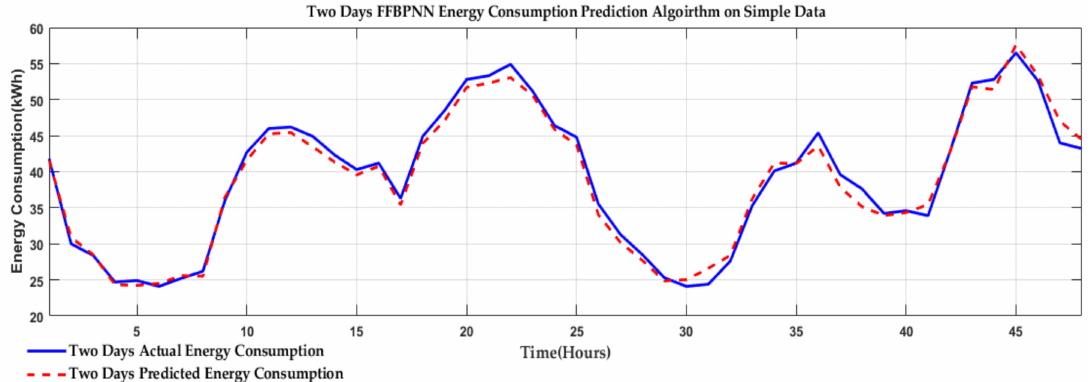
Figure 11. Five days of hourly energy consumption prediction using FFBPNN on simple data.